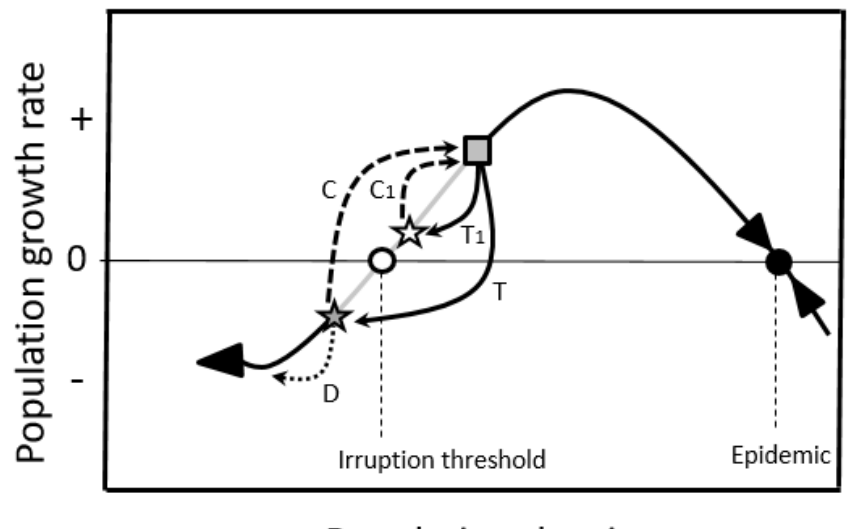
Figure 4. Hypothetical recruitment curve for rising spruce budworm populations with different intensities of treatment mortality and possible population responses. The gray box represents the starting point of a treatment (e.g., with an insecticide) with its potential impacts on population density and growth rate indicated by the stars. Relatively high (and additive) treatment mortality (T) may return populations to the lower equilibrium (gray star) where depensatory pressure (D) should keep populations low in the absence of a strong compensatory response (C). On the other hand, inadequate treatment mortality (T 1 ) and even modest compensation (C 1 ) could allow populations to rebound (thick dashed lines) and continue the outbreak.